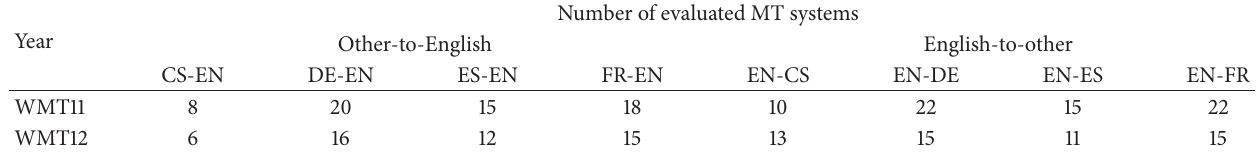
Table 5: The number of effective MT systems in WMT11 and WMT12.